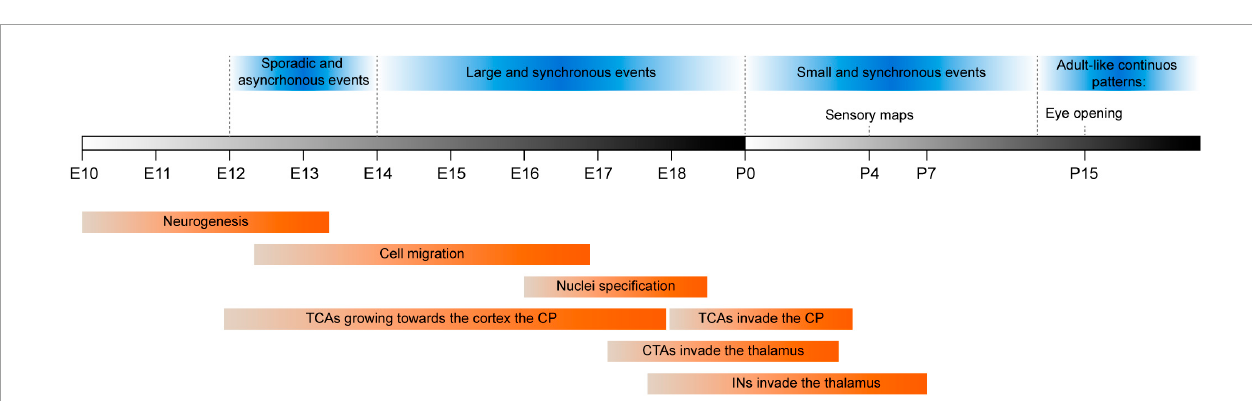
FIGURE4 Timeline showing milestones in mouse thalamic development (red boxes). The different patterns of spontaneous thalamic activity throughout development (blue boxes). First, thalamic spontaneous activity is characterized for being scarce and the events are uncorrelated (E12-E14). This is followed by waves of spontaneous activity (E14-P0) that propagate among FO and then HO nuclei. At perinatal stages, these waves disappear and instead, there are small events most likely triggered spontaneously from peripheral organs that engage cortical areas. Before eye opening, there is a switch to an adult-like pattern where spontaneous activity becomes dense, asynchronous and continuous (Colonnese et al., 2010). CP, cortical plate; CTAs, corticothalamic axons; E, embryonic day; Ins, interneurons; P, postnatal day; TCAs, thalamocortical